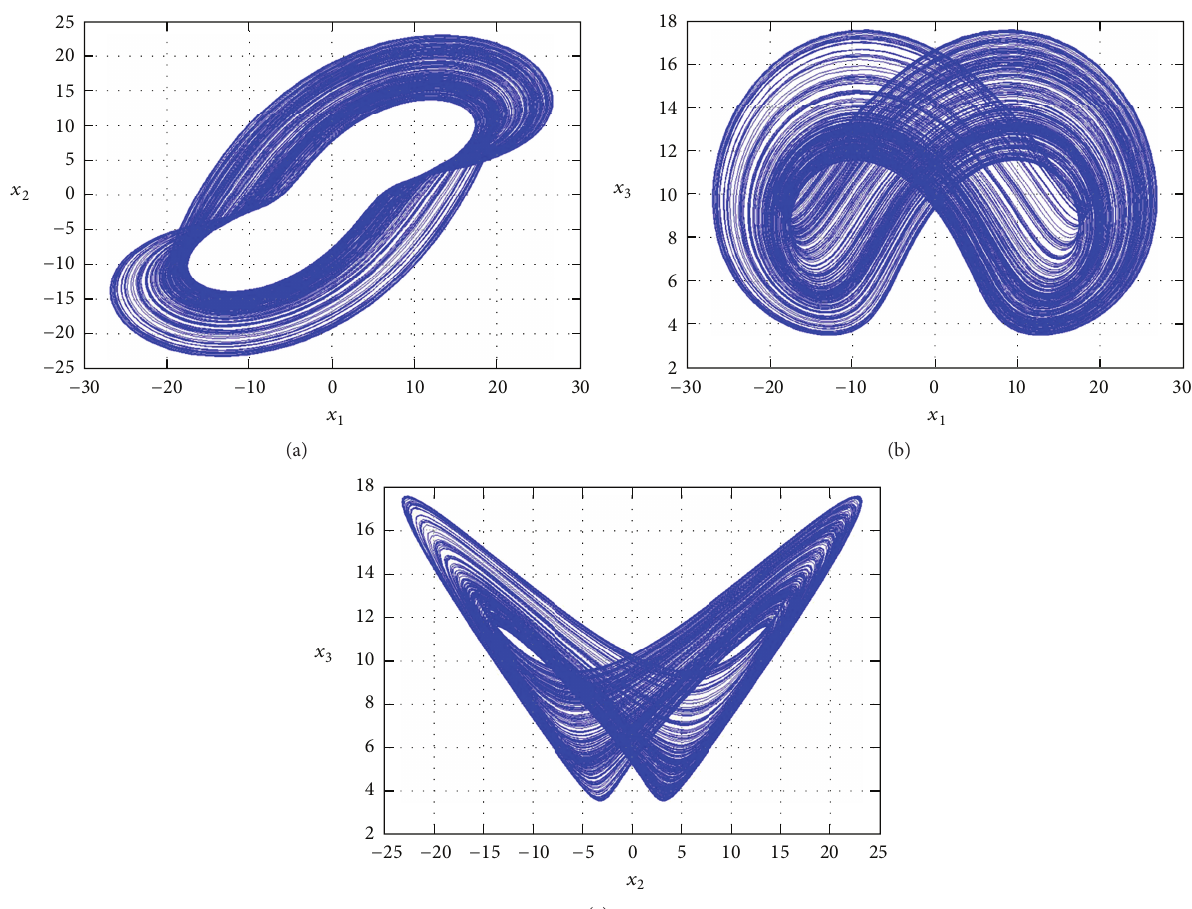
Figure 6: Projection of phase portraits in MATLAB for fuzzy chaotic Chen-Lee